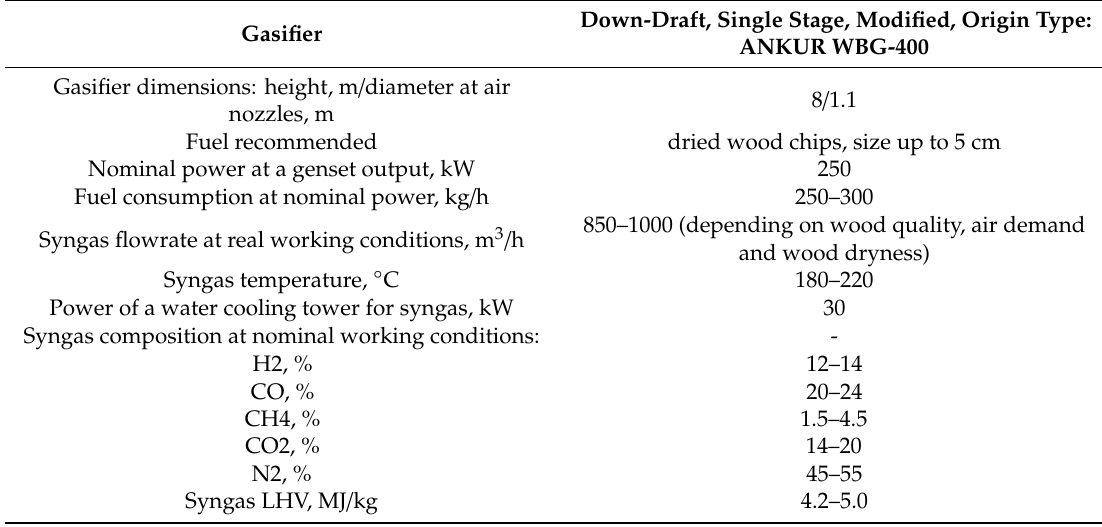
Table 2. Gasification system